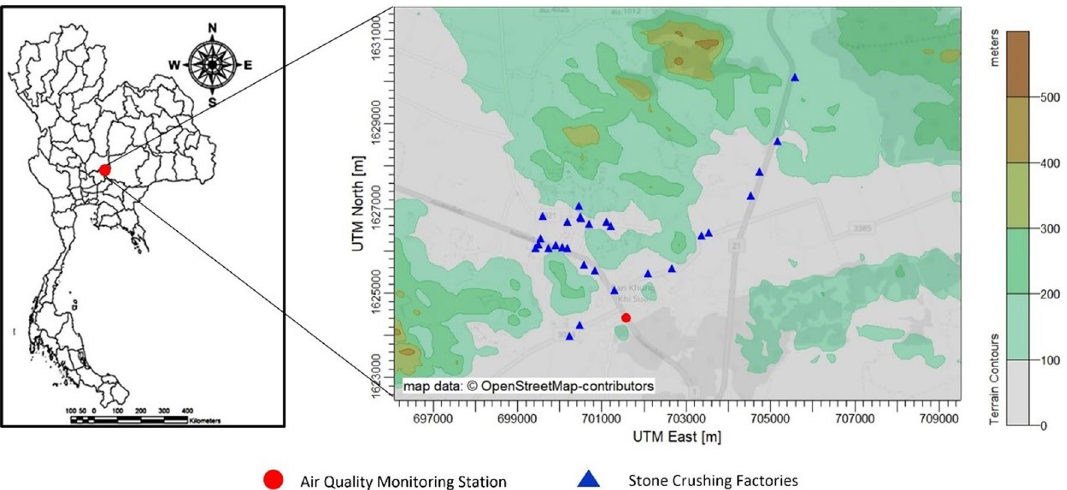
Figure 1. Study area and the location of air quality monitoring station located in Na Phra Lan Subdistrict (a map was created using AERMOD View 9.8.1, www.webla kes.com/produ cts/aermo